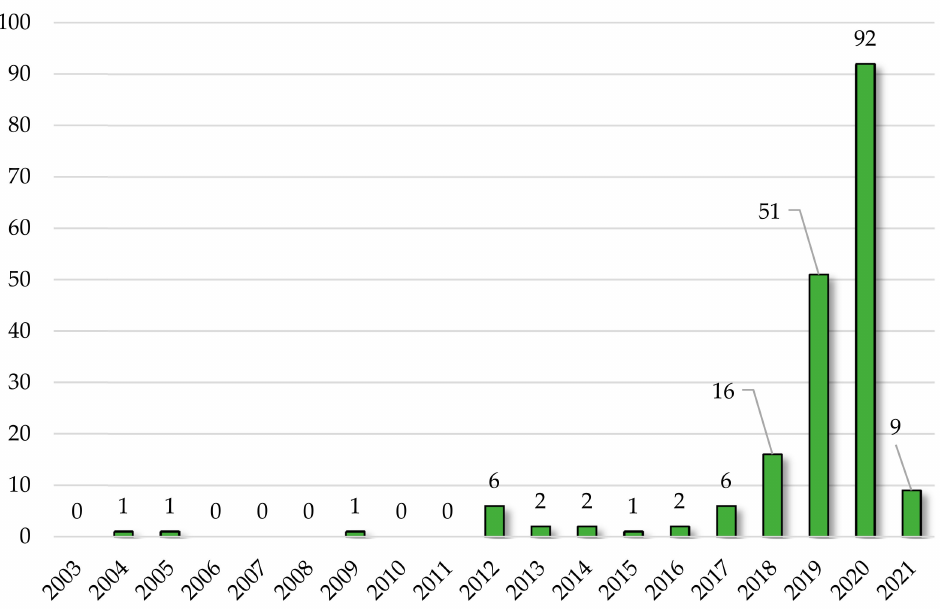
Figure 10. Annual publication trend of 3301 documents retrieved from Scopus for the intersection between the DT and safety research fields in the period 2003–2021. Table 3. Top ten affiliated countries publishing in the intersection of the DT and safety research fields.